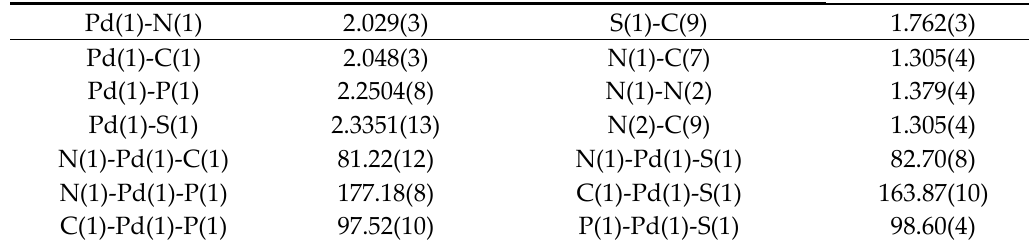
Table 5. Selected bonds (Å) and angles (°) for compound 1c